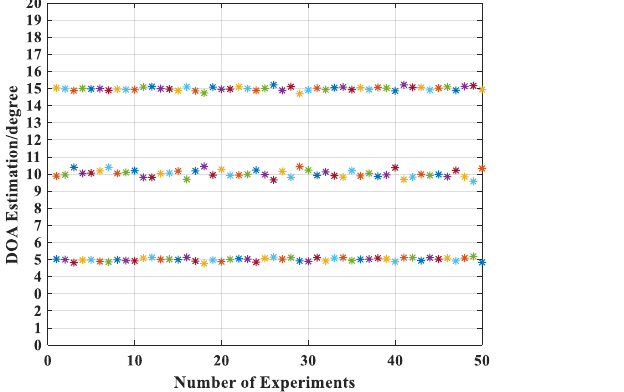
12 of 20 Figure 2. The distribution of